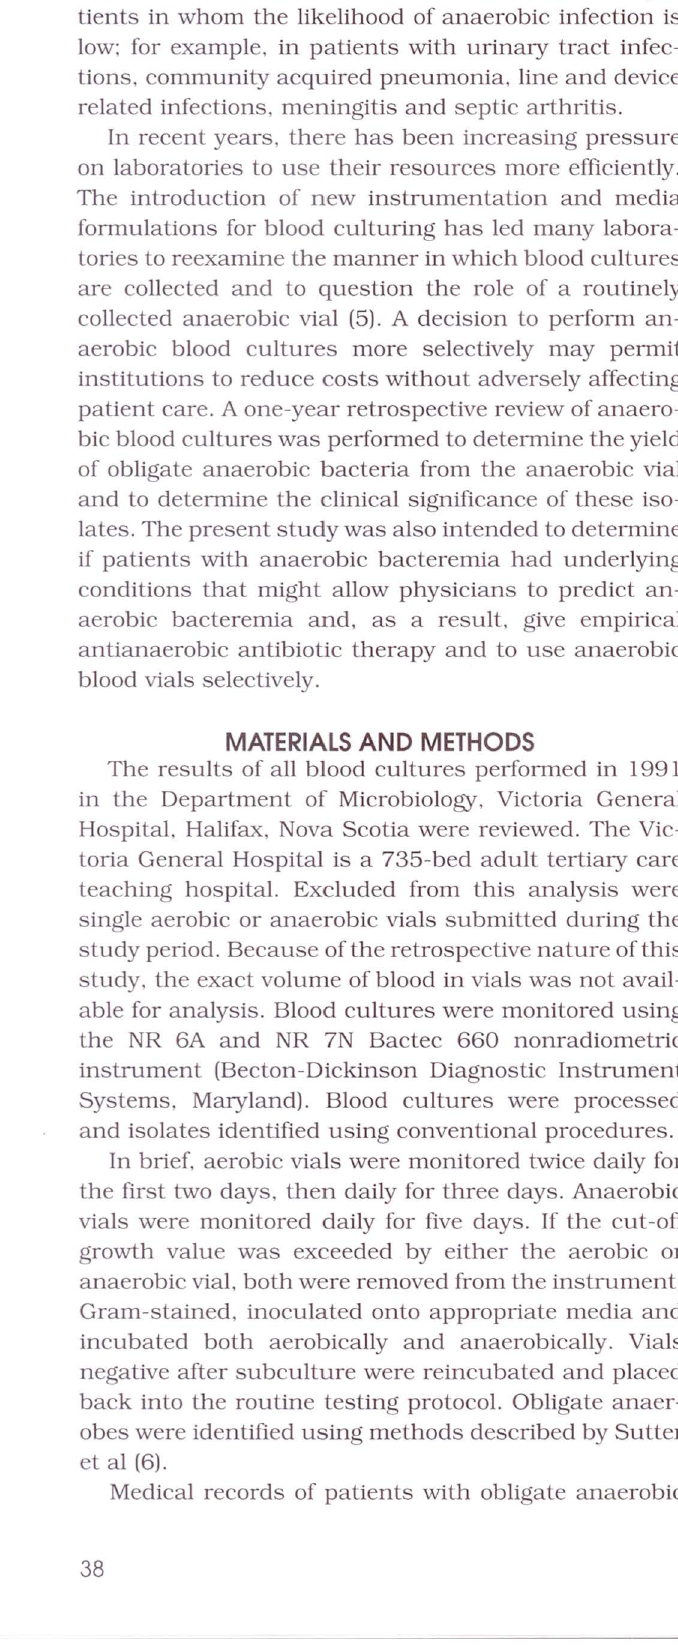
Summary of isolates from aerobic and anaerobic blood culture vials processed at the Victoria General Hospital in